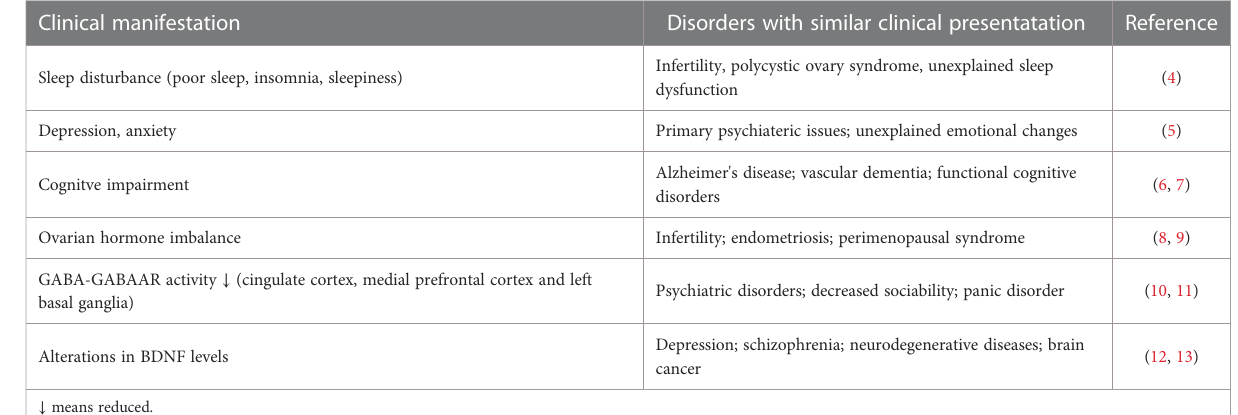
(Table 1). In a study of 127 medical students with PMS, 96 of